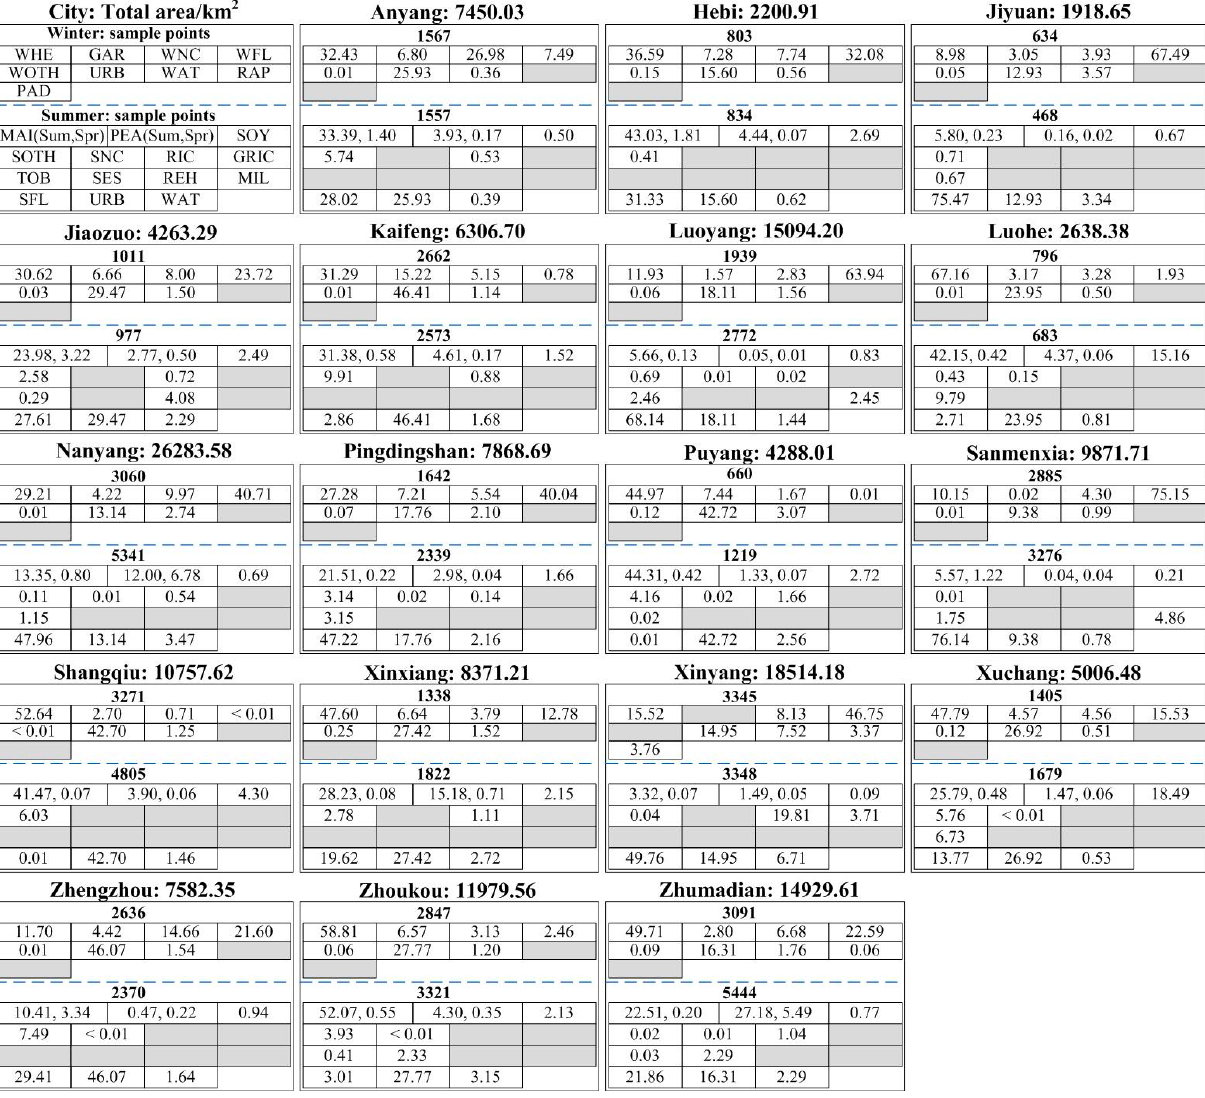
Figure 11. Information of all subregions, including name, total area, categories, sample points, and area proportion. The first subgraph represents the template for displaying the results. The value of each land use type is the percentage of classification–area of the subregional total area. Moreover, (Sum, Spr) represents the area proportion during summer and spring, and the gray–cells indicate that this category is not classified in the subregion. Table 5. Multi–season area proportion of different landcover types and comparison with the results in 2018 (%).